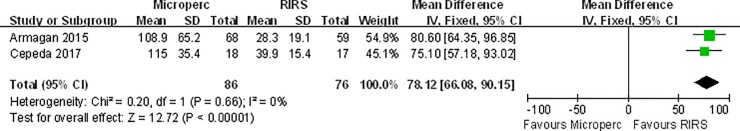
Forest plot for comparison of fluoroscopy time between Microperc and RIRS groups.